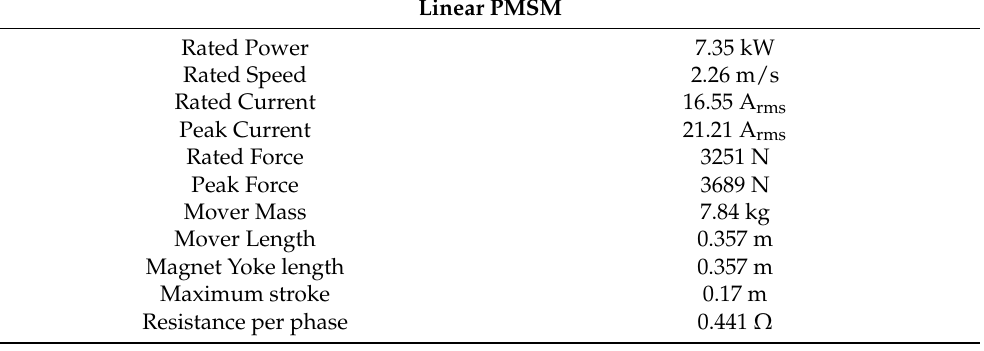
Table 2. Characteristic data of the developed electrical machine.